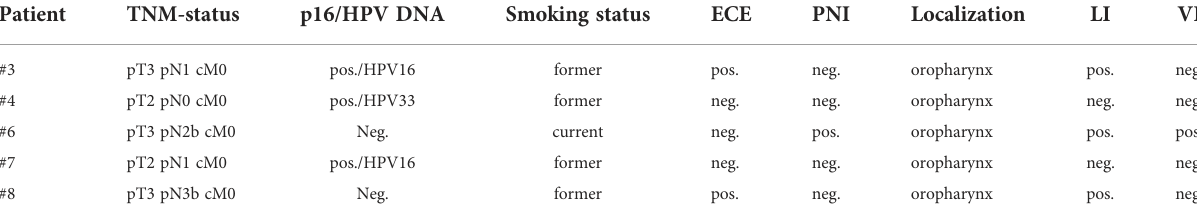
TABLE 1 Clinical parameters of OPSCC patients. ECE, extracapsular extension; PNI, perineural invasion; LI, lymohatic invasion; VI, vascular invasion.